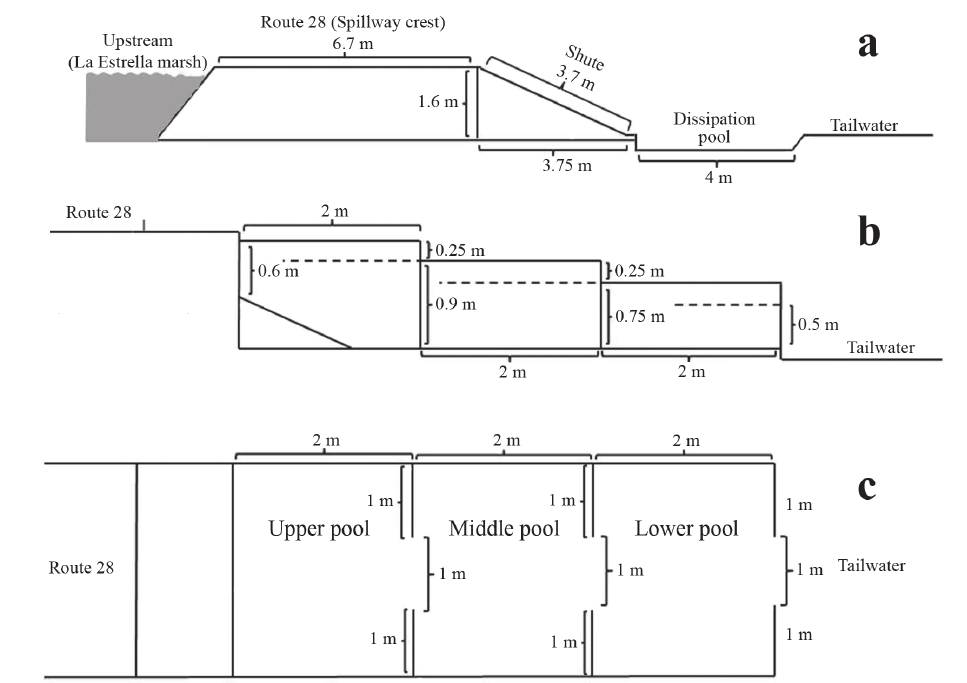
Fig. 3 . View of spillway ( a ) and pools and weir systems ( b , c ) design.